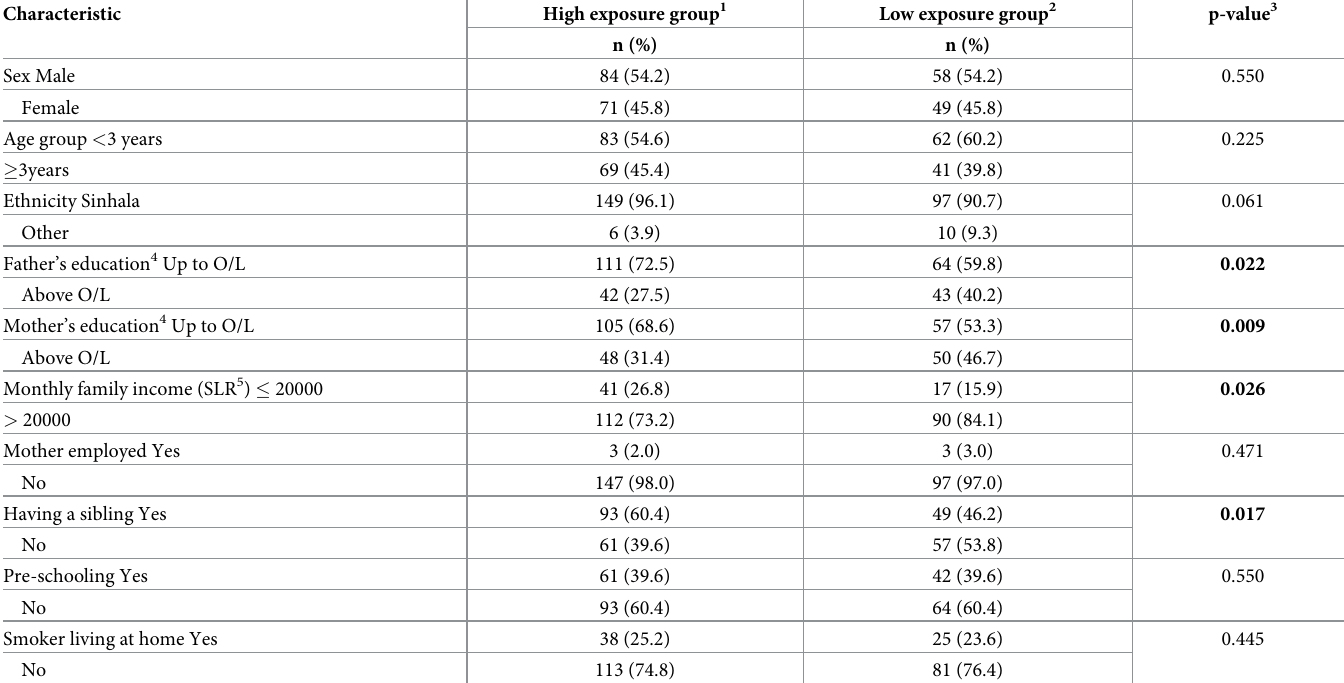
Table 1. Socio-demographic characteristics of the study